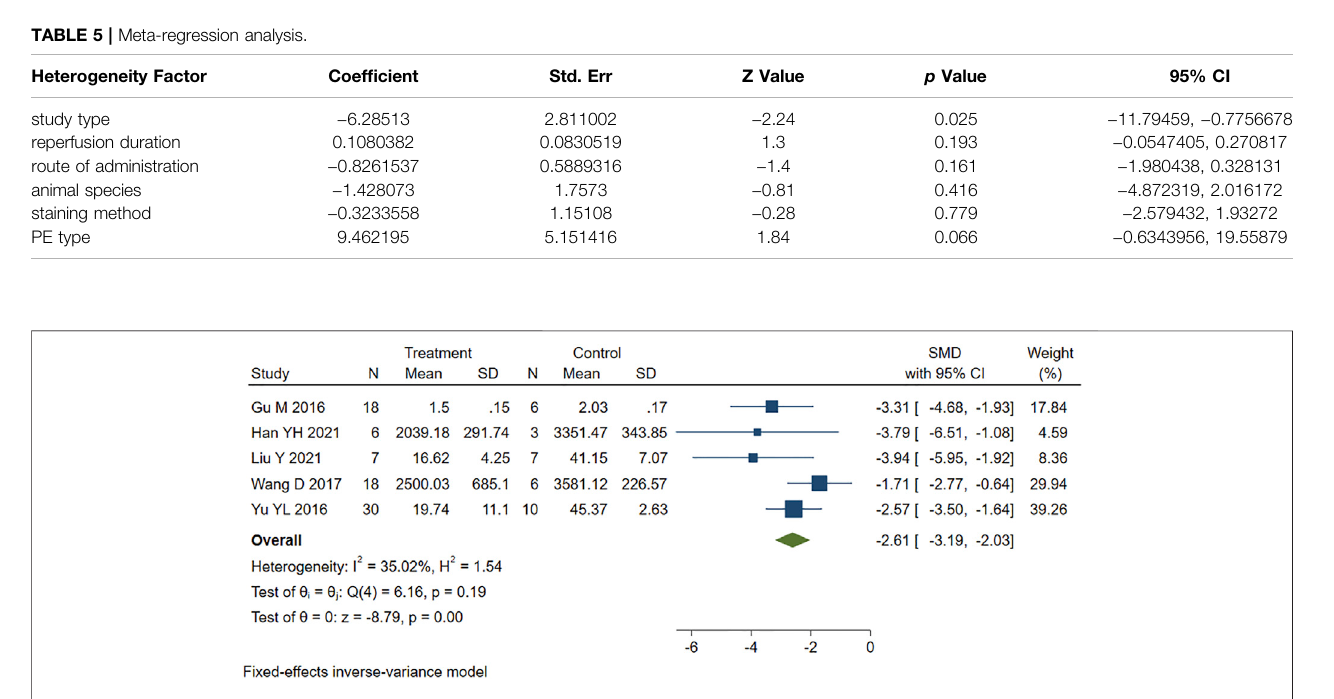
FIGURE 3 | Forest plot to study the effect of PE on creatine kinase (CK). PE reduced serum CK levels in MIRI animals compared to control group (SMD = − 2.61, 95%CI: − 3.19to − 2.03, p < 0.001).Thedarksquaresrepresentthestandardizedmeandifference(SMD)foreachstudy.ThediamondsrepresentthepooledSMD.95% of the CIs are indicated by lines. The analysis was conducted using a fi xed-effects model.